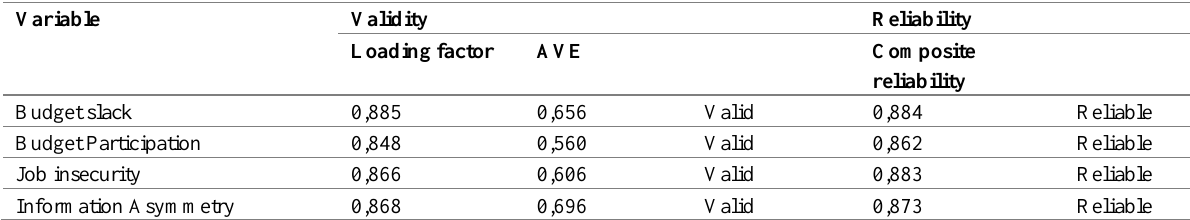
Table 4: V alidity and reliability test results